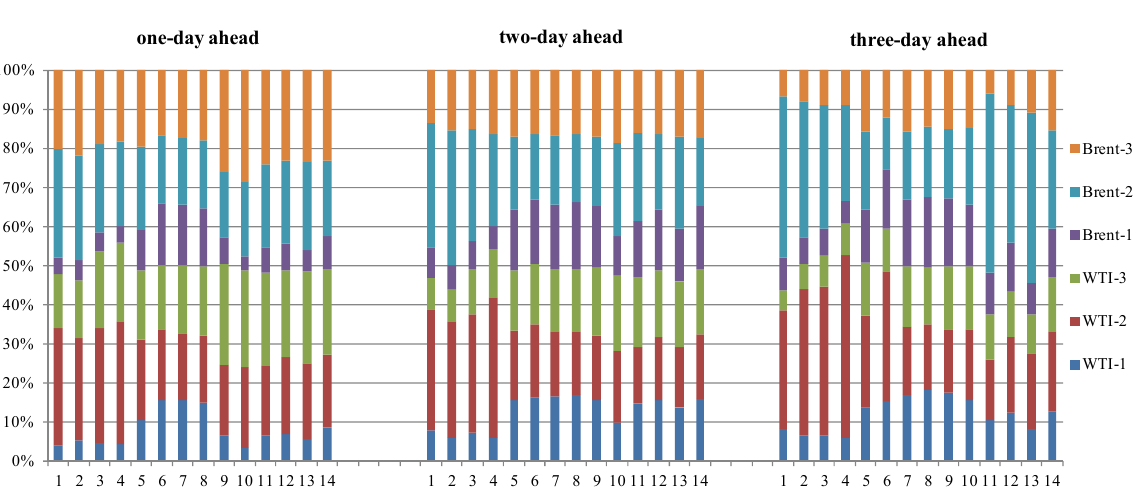
Figure 3. Coefficients of MKR of one-day, two-day, and three-day ahead predictions for WTI crude oil price (14 experiments for each time horizon).